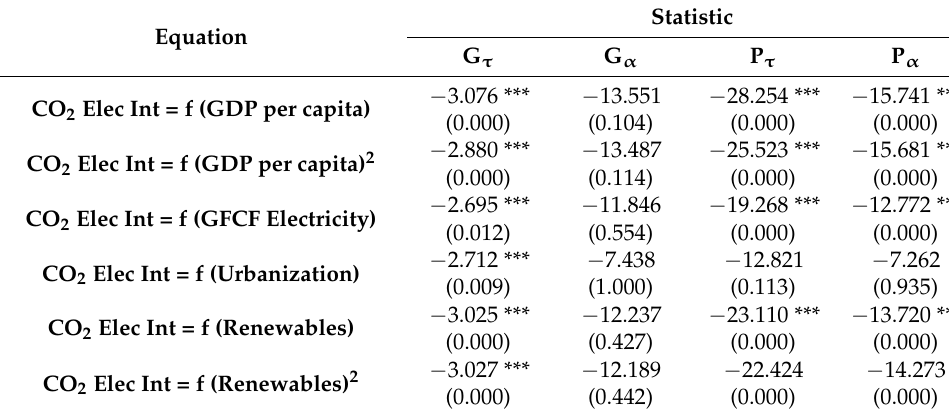
Table 8. Westerlund panel cointegration test.